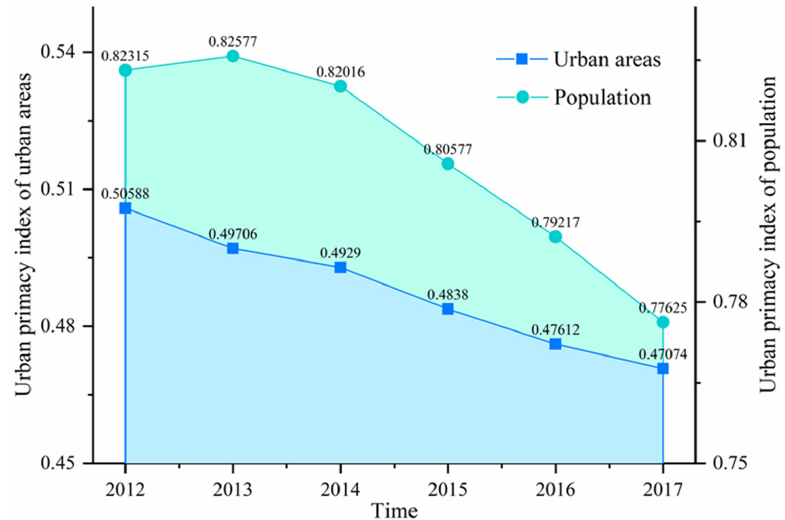
Figure 7. Variations in urban primacy index for extracted urban areas and the statistic population data of the YRD from 2012 to 2017.